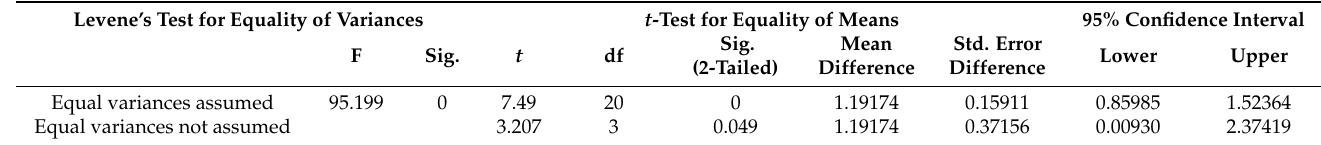
Table 4. The t -test results of the two data segments.